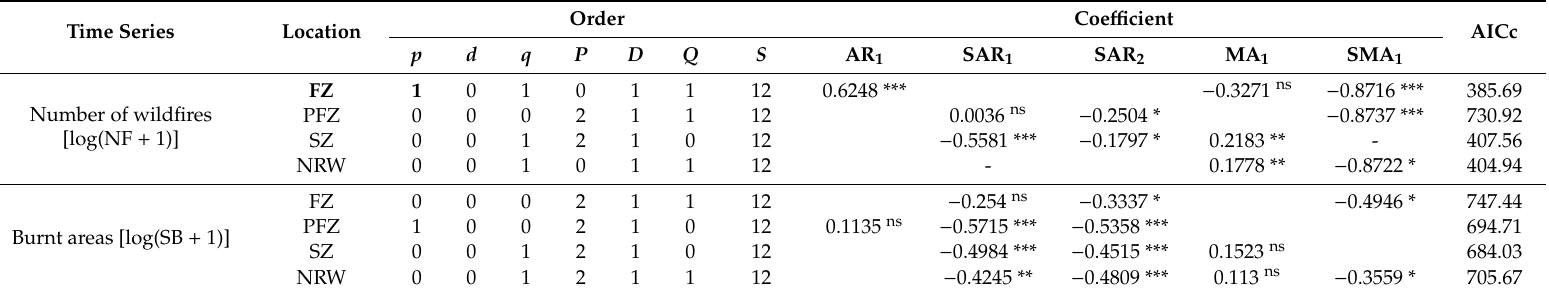
Table 2. Summary of fitted autoregressive integrated moving average (ARIMA) models to the input time series of log(NF + 1) and log(SB +